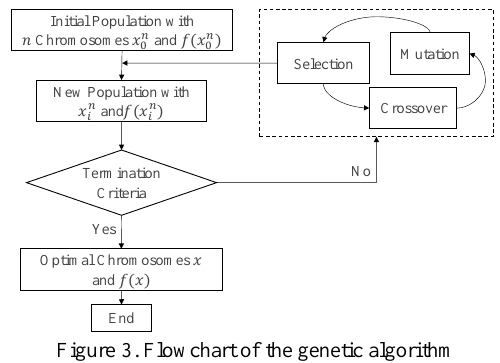
Figure 3. Flowchart of the genetic